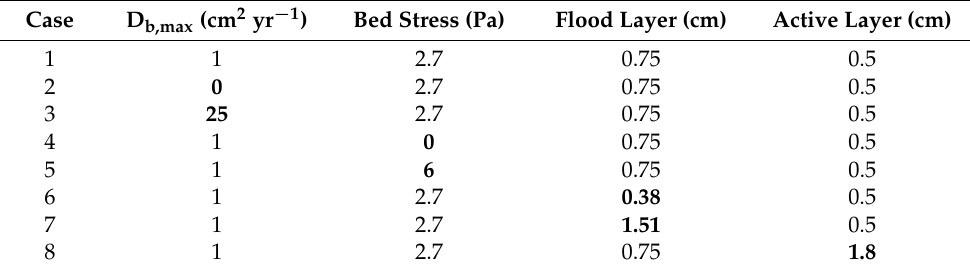
Table 1. Parameters for each model run. Bold print marks the parameters that differ for Cases